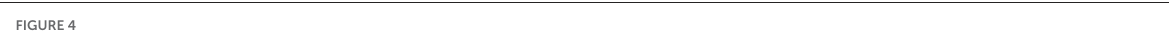
FIGURE4 under the receiver operating characteristic curve. Serum annexin A7 levels were dramatically higher in patients suffering from early neurological deterioration than in those who did not using Mann–Whitney U test ( P < 0.001). Serum annexin A7 levels significantly discriminate risk of early neurological deterioration with an area under the curve at 0.781 (95% confidence interval: 0.698–0.849). Using maximum Youden index, serum annexin A7 levels above 57.4ng/ml differentiated development of END with medium-high sensitivity and specificity. END, early neurological deterioration.